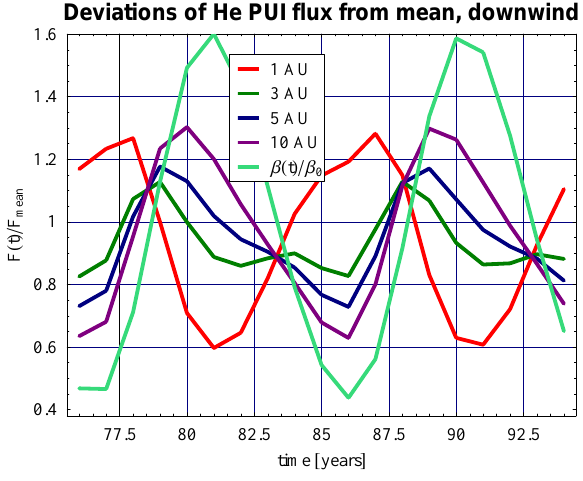
Fig. 12. Ratios of the He PUI flux averaged over solar cycle to the stationary flux calculated for the ionization rate averaged over the solar cycle for the upwind (red), crosswind (green), and downwind (blue) directions.